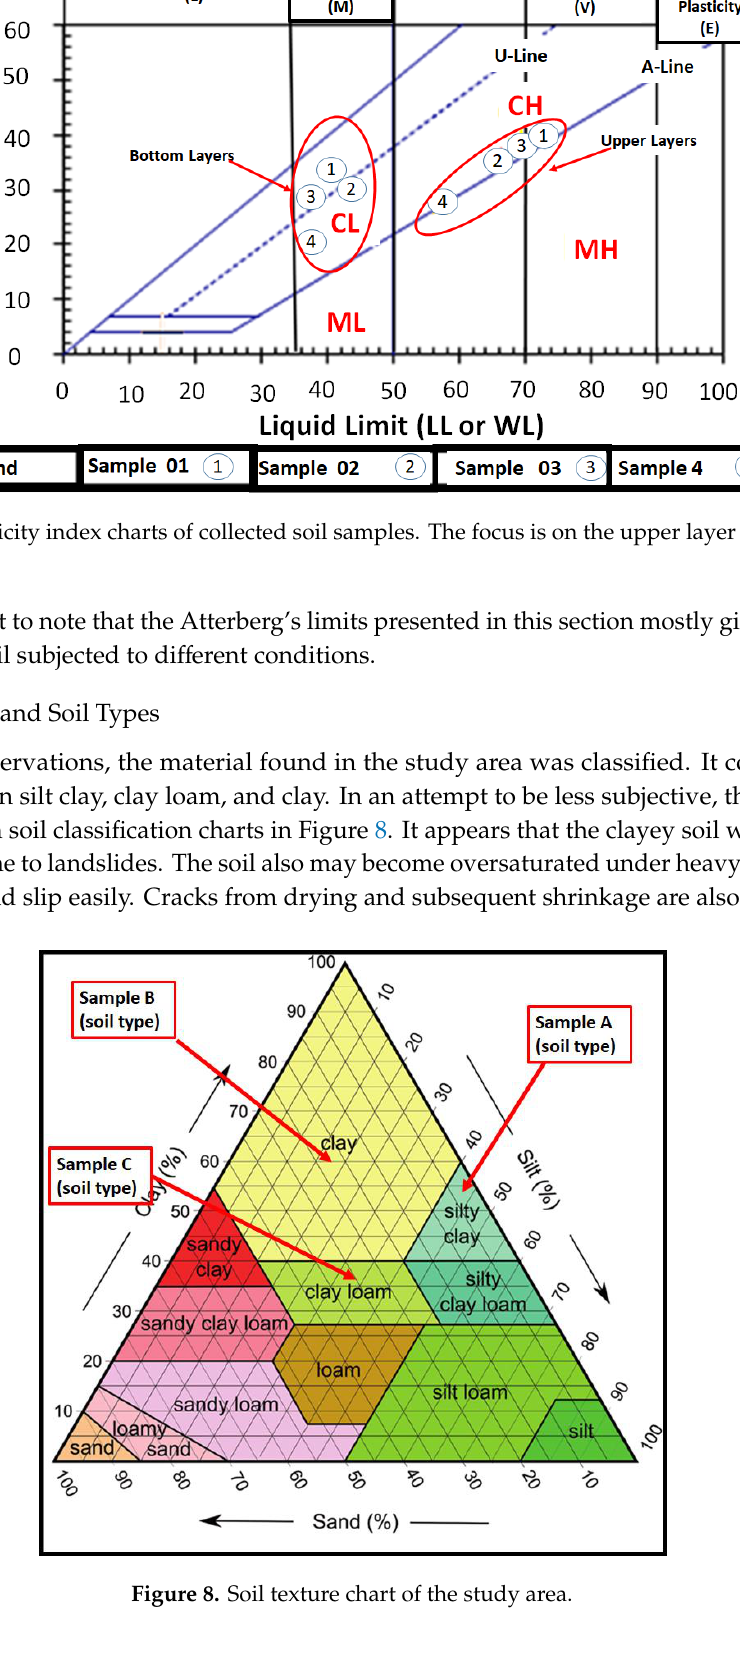
Figure 8. Soil texture chart of the study area.